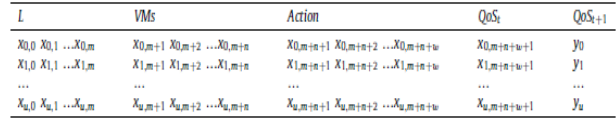
Table 1. Past event data used for training the iterative QoS